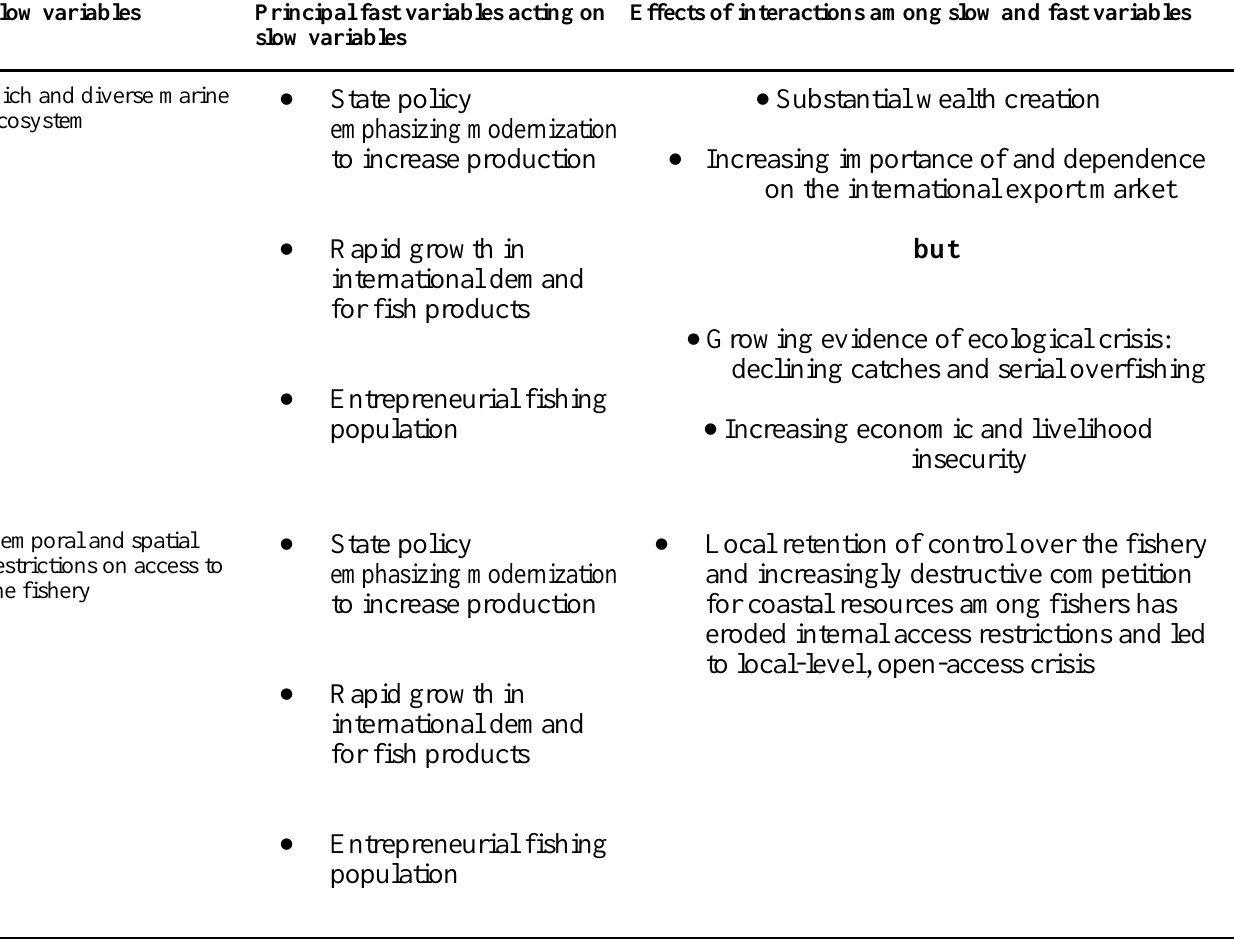
Table 1. Globalization and resilience in Junagadh District, Gujarat. Slow